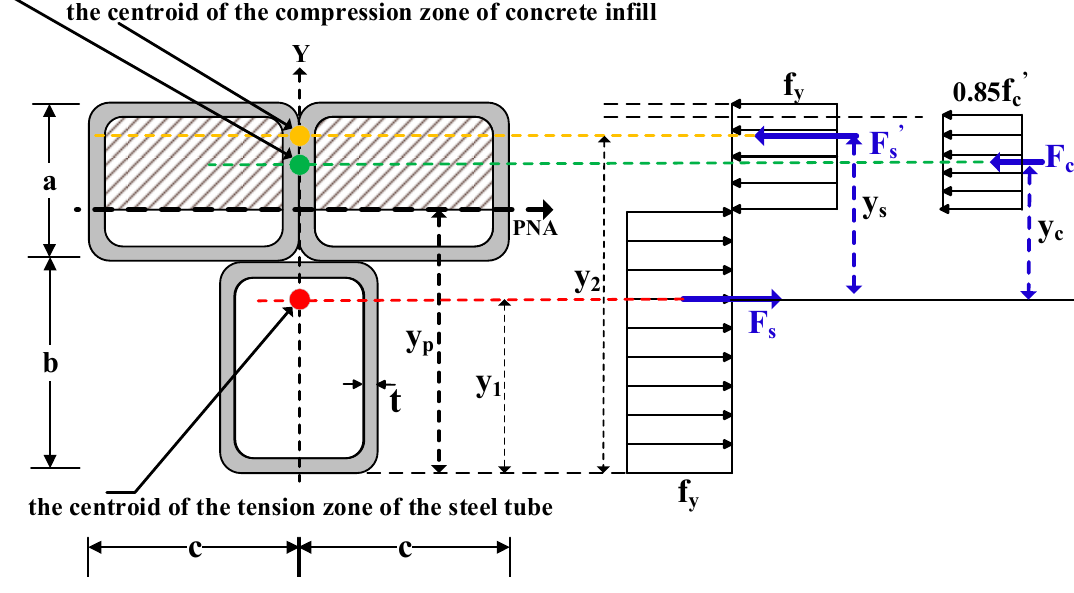
Figure 4. Plastic stress distribution for an MT-CFST compact section under positive bending.